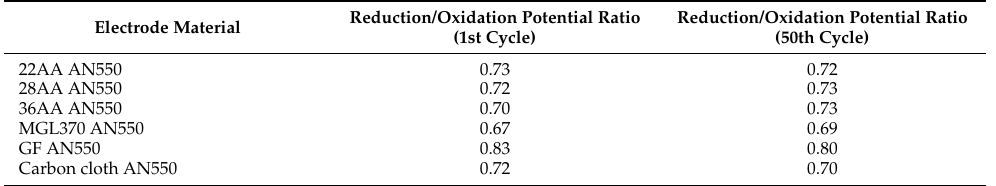
Figure 8. Potential responses during bromine oxidation/reduction at ± 100 mA cm −2 for 10 min on annealed carbon electrode materials; ( a , c ) the first 5 cycles, ( b , d ) 50 cycles. 3 M HBr/1 M Br 2 electrolyte, working electrode area 0.1 cm 2 . Temperature 25 °C. Table 3. Reduction to oxidation potential ratios of bromine electrode reaction obtained from the annealed carbon samples.